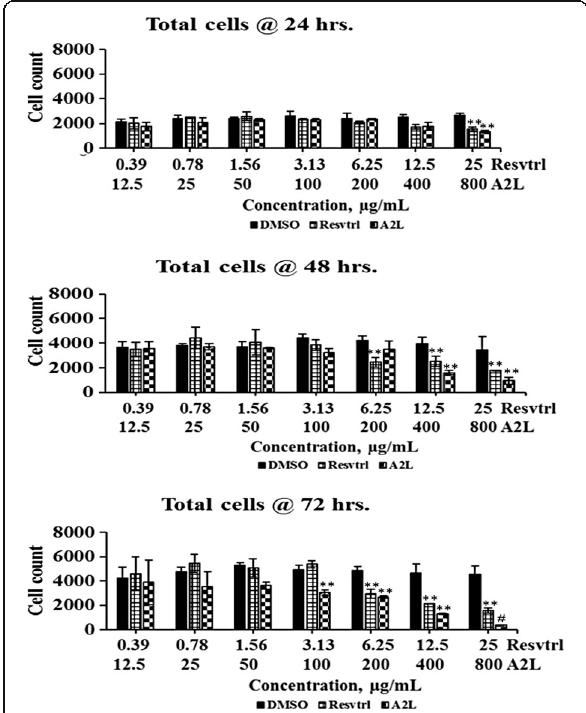
Fig. 1 Determination of total cells. Numerical changes associated with treatment of HepG2 cells with resveratrol (Resveratrol) or extract (A2L) followed up for three days. * p < 0.05; ** p < 0.01; # p < 0.001